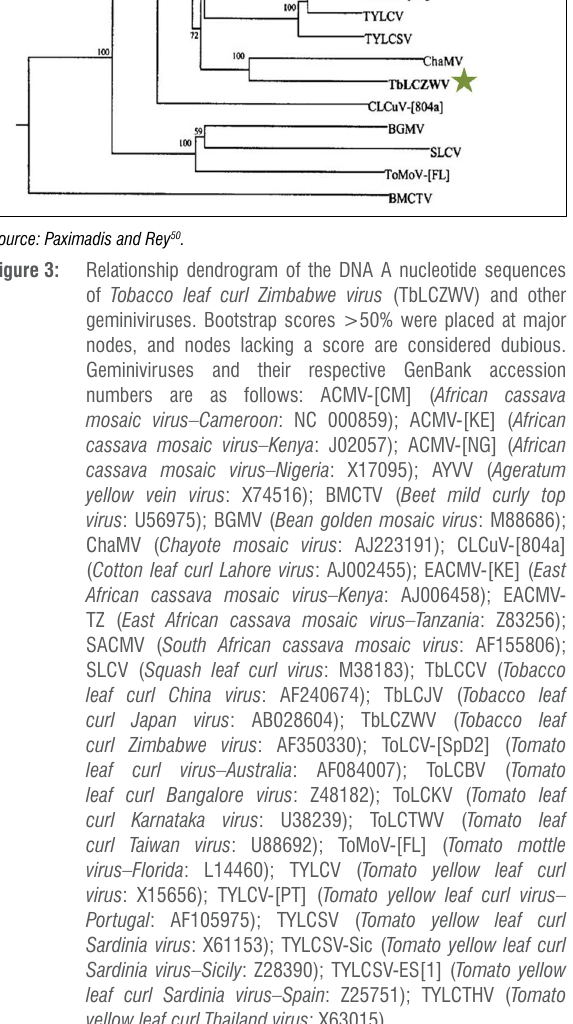
yellow leaf curl Thailand virus :